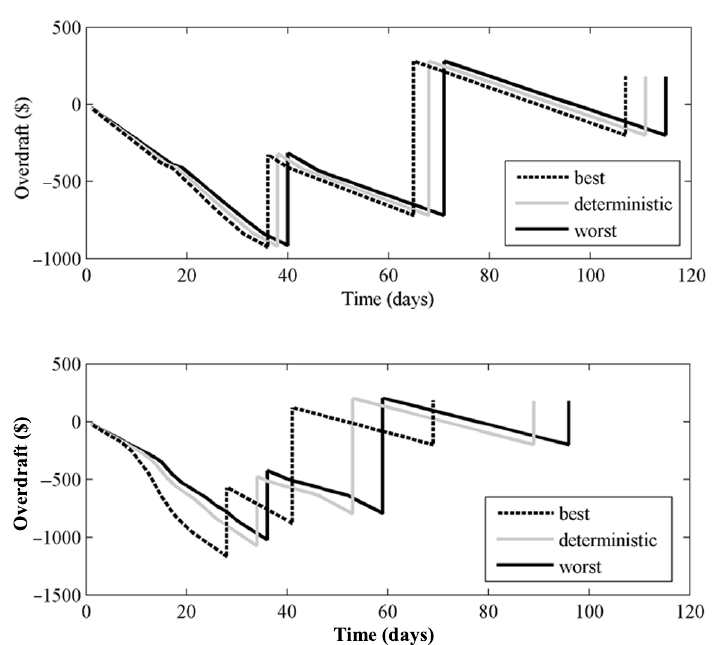
Fig. 17. Maximum overdraft at three possibility levels without task overlaps (top) and with task overlaps (bottom)